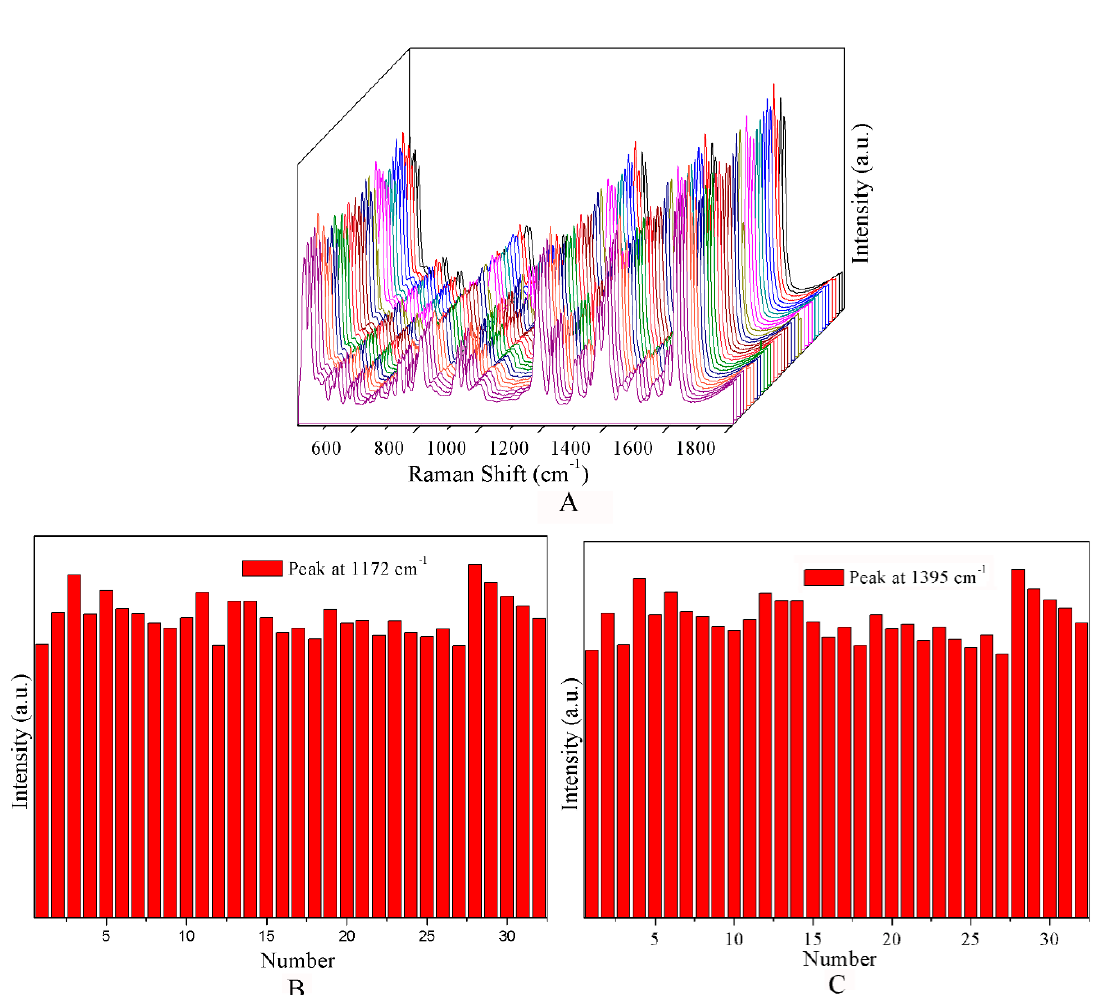
Figure 3. ( A ) SERS spectra of different concentrations of MG. ( B , C ) Graphs of the intensity of the peaks at 1172 and 1395 cm − 1 from 32 SERS spectra of the dried sample of ( B ).